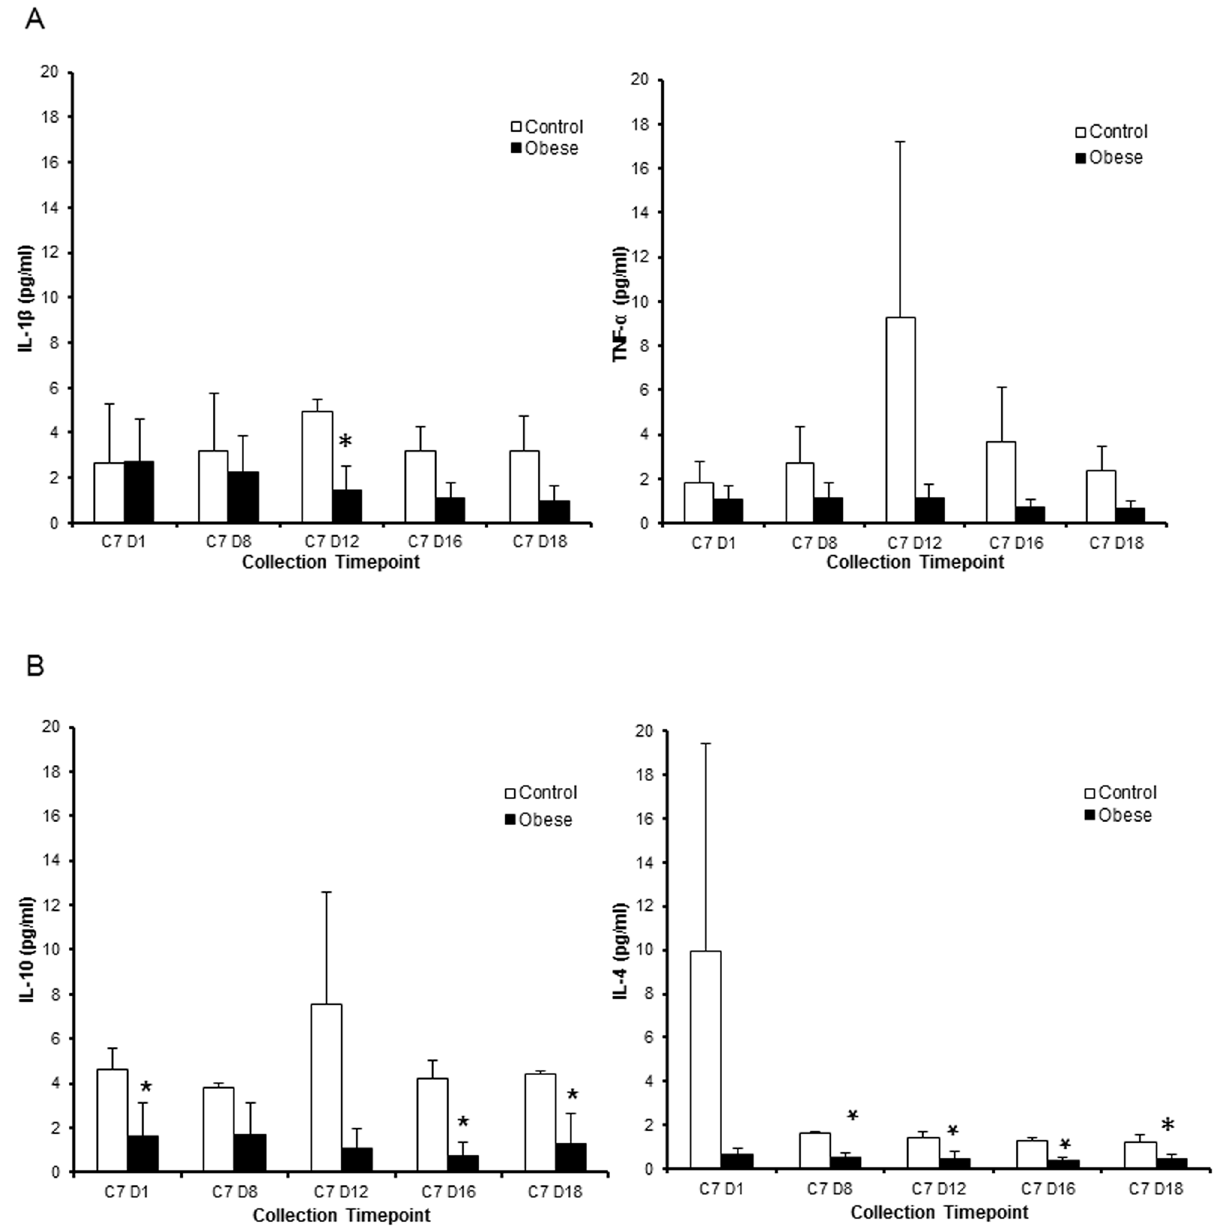
Fig 1. Serum cytokine measurements throughout cycle 7 (dietary maintenance) in obese and lean pigs. (A) Levels of pro- inflammatory cytokines IL-1 β and TNF- α . (B) Levels of anti-inflammatory cytokines IL-10 and IL-4. Results are expressedas least squared mean fluorescent intensity ± SEM (obese, n = 3; control, n = 2). All data have been normalized to cycle 1 day 1 for each individualanimal. * indicatesP < 0.05.